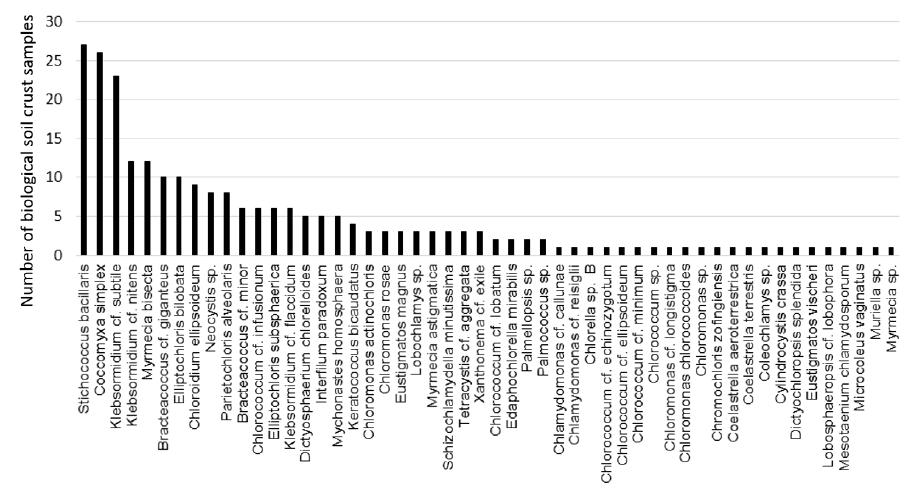
Figure 2. Occurrence of each algal species in biological soil crusts from forest sites ( n = 31).